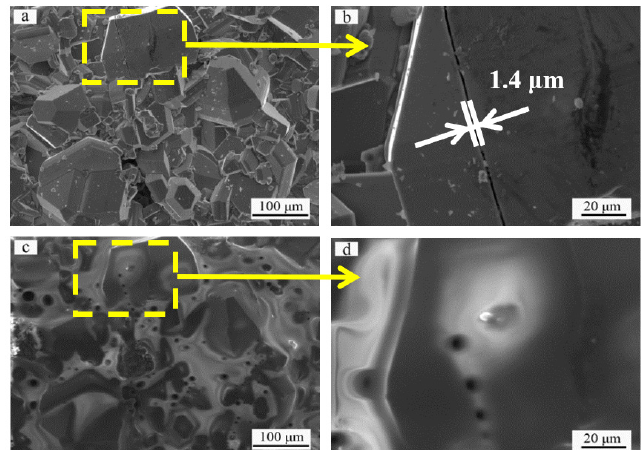
Figure 3. Surface morphologies of the SiC coating: ( a ) original surface before oxidation, ( b ) magnified image of the selected area in ( a ) showing a typical crack with 1.4 μ m in width, ( c ) top view of the same area in ( a ) after oxidation, ( d ) magnified image of the selected area in ( c ) showing the healing of the crack.